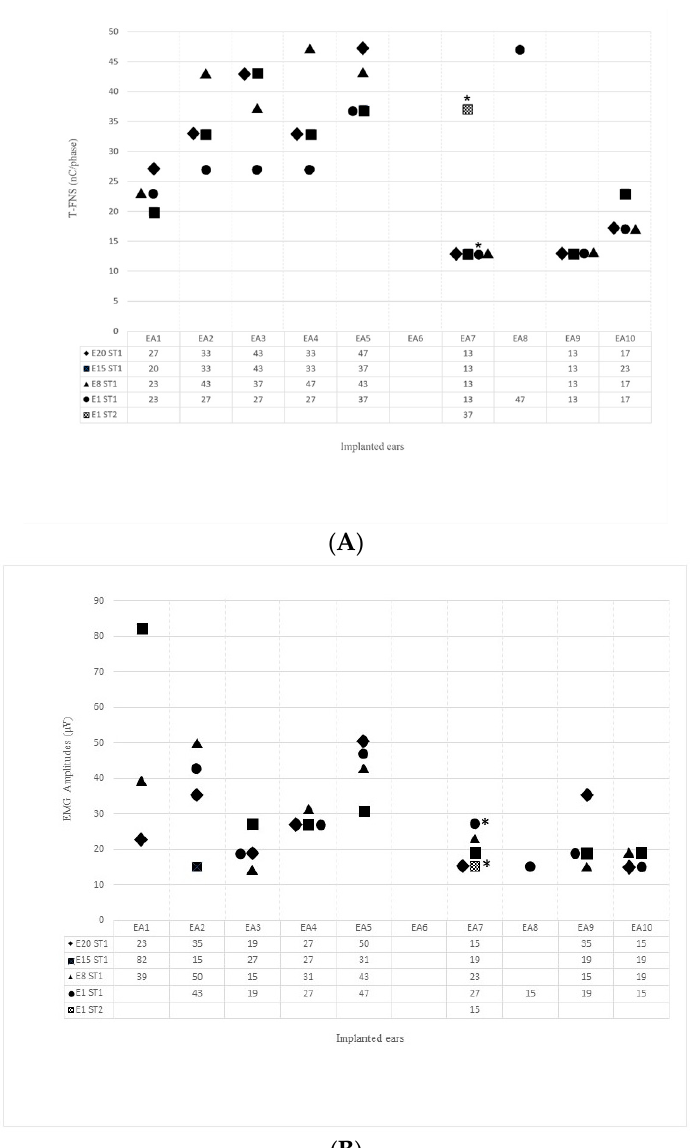
Figure 3. Individual T-FNS ( A ) and EMG amplitudes ( B ), when recorded, using CI stimulation patterns ST1 and ST2. Blank: no EMG responses. EA1–EA10: implanted ears 1–10. *Asterisks: comparison between values recorded with ST1 and ST2, in the same electrode (#Subject 4, EA7).